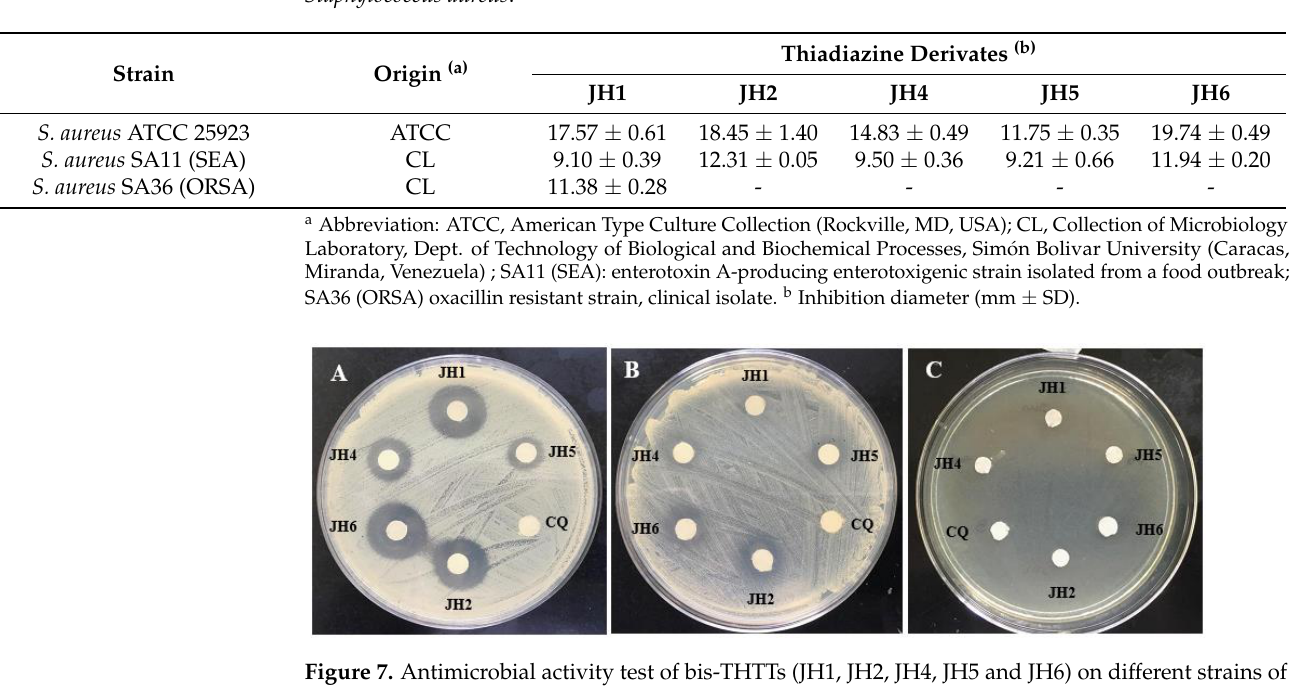
Figure 6. In vitro antimicrobial activity of bis-THTTs (JH1, JH2, JH4, JH5 and JH6) on Gram-negative bacteria. ( A ): Salmonella enteritidis CVCM 497, ( B ): Escherichia coli ATCC 25922, ( C ): Pseudomonas aeruginosa ATCC 10145. CQ was used as the positive control. Table 5. Antimicrobial activity of bis-THTTs (JH1, JH2, JH4, JH5 and JH6) on different strains of Staphylococcus aureus.